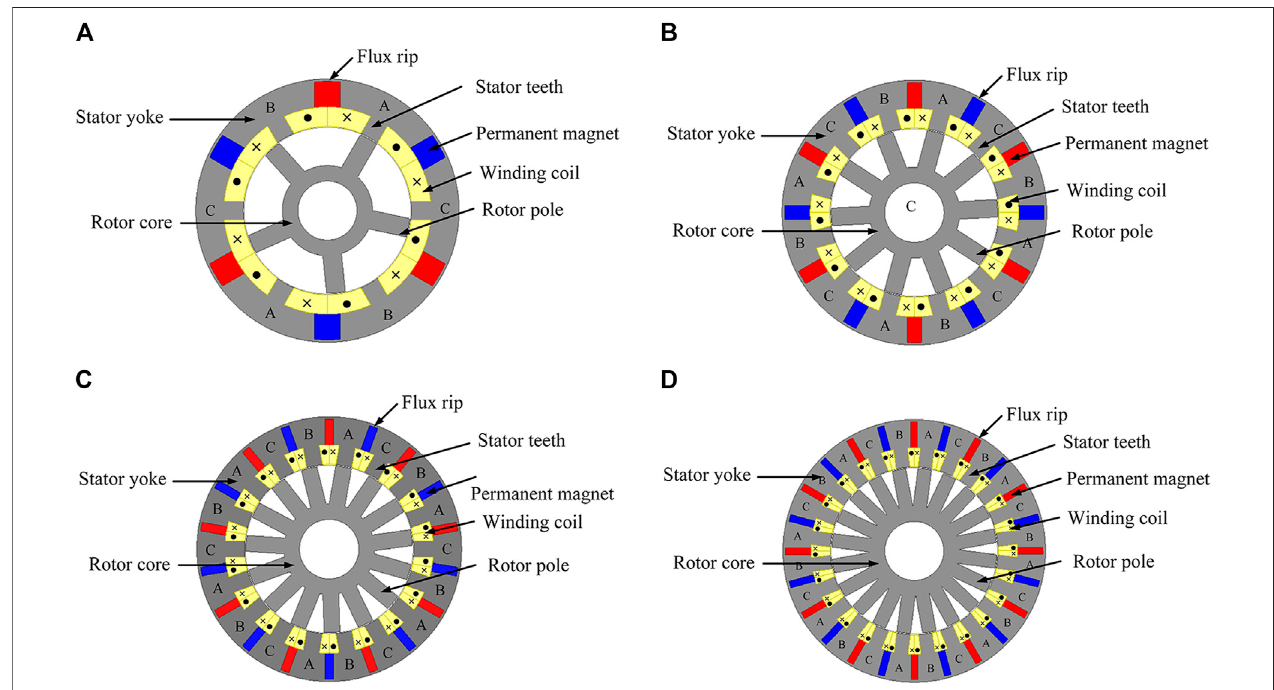
FIGURE 1 | The cross-sectional perspective of DSPM with (A) 6/5, (B) conventional 12/10, (C) 18/15, and (D) 24/20-poles.